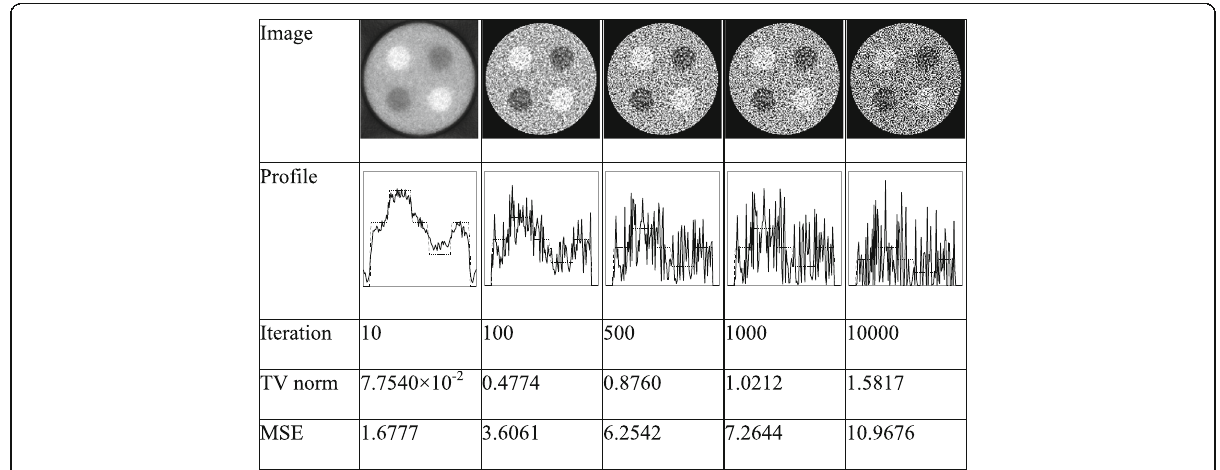
Fig. 2 Reconstructions of emission data using the conventional ML-EM